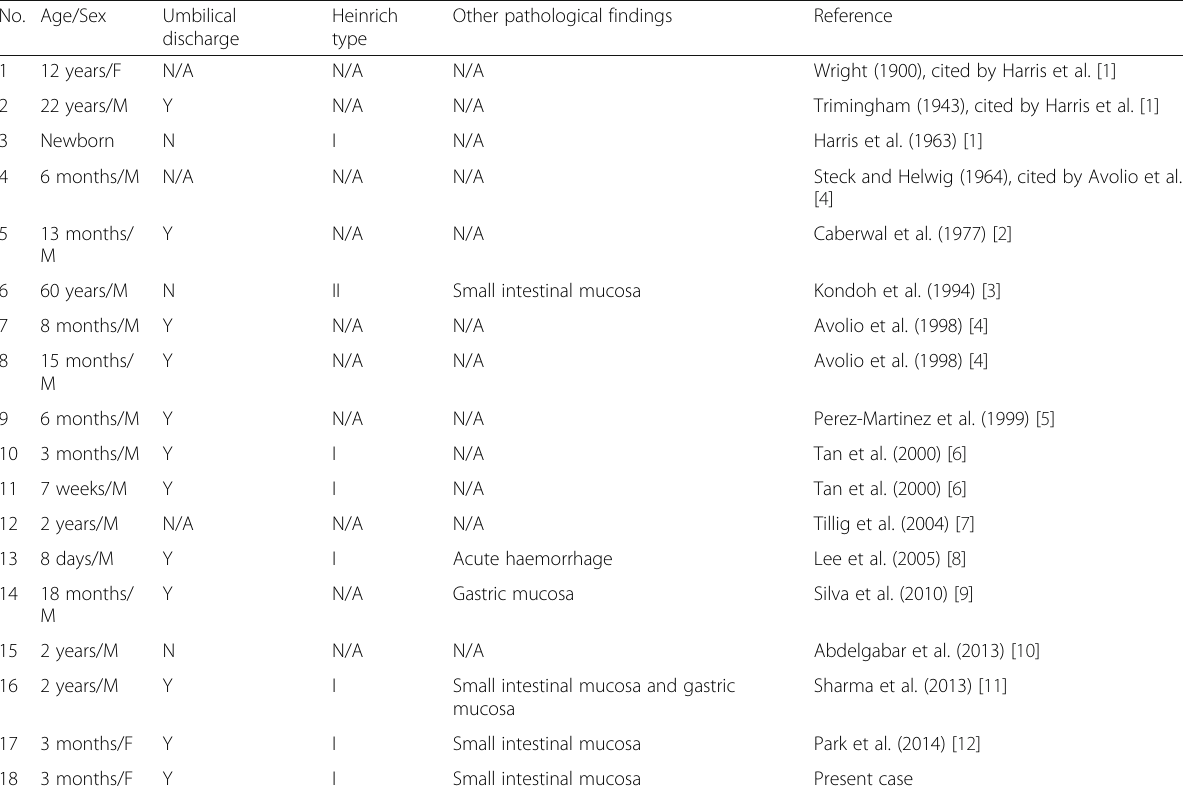
Table 1. Summary of cases of heterotopic pancreas at the